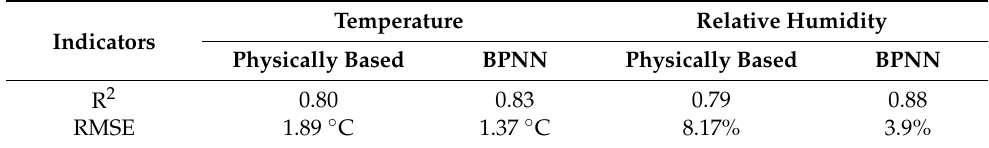
Table 5. Performance of the physically based estimation model and the BPNN prediction model with respect to greenhouse internal temperature and relative humidity based on test datasets. Temperature Relative Indicators